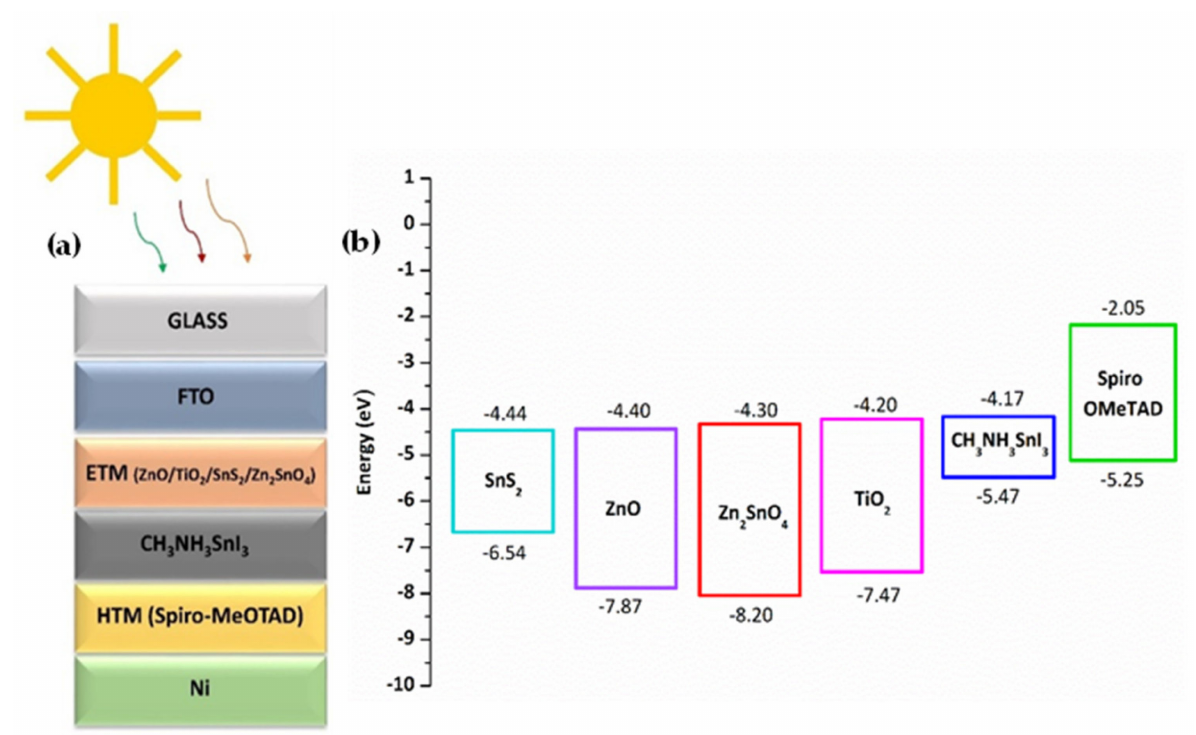
Figure 1. ( a ) Device architecture of the Sn based perovskite solar cell and ( b ) Energy band alignment for the proposed